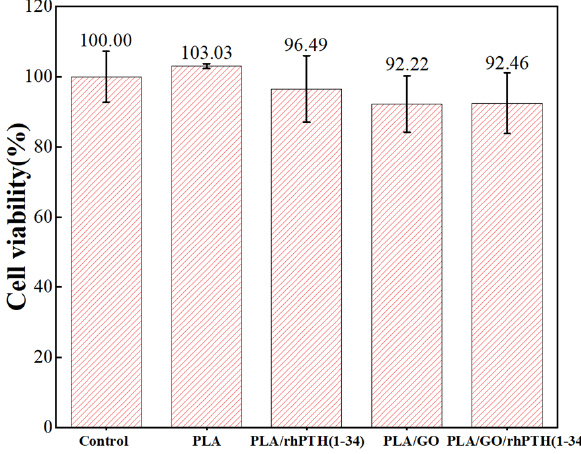
Figure 5. MTT assay of 2-day cell survival on the surfaces of composite membranes (Notes: p > 0.05 stands for no significant difference).